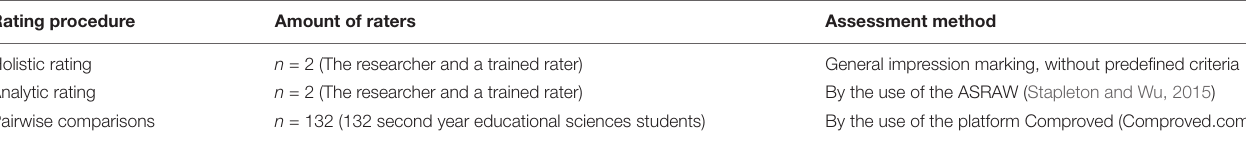
TABLE 1 | Overview of the used rating procedures, the amount of raters, and the assessment methods.